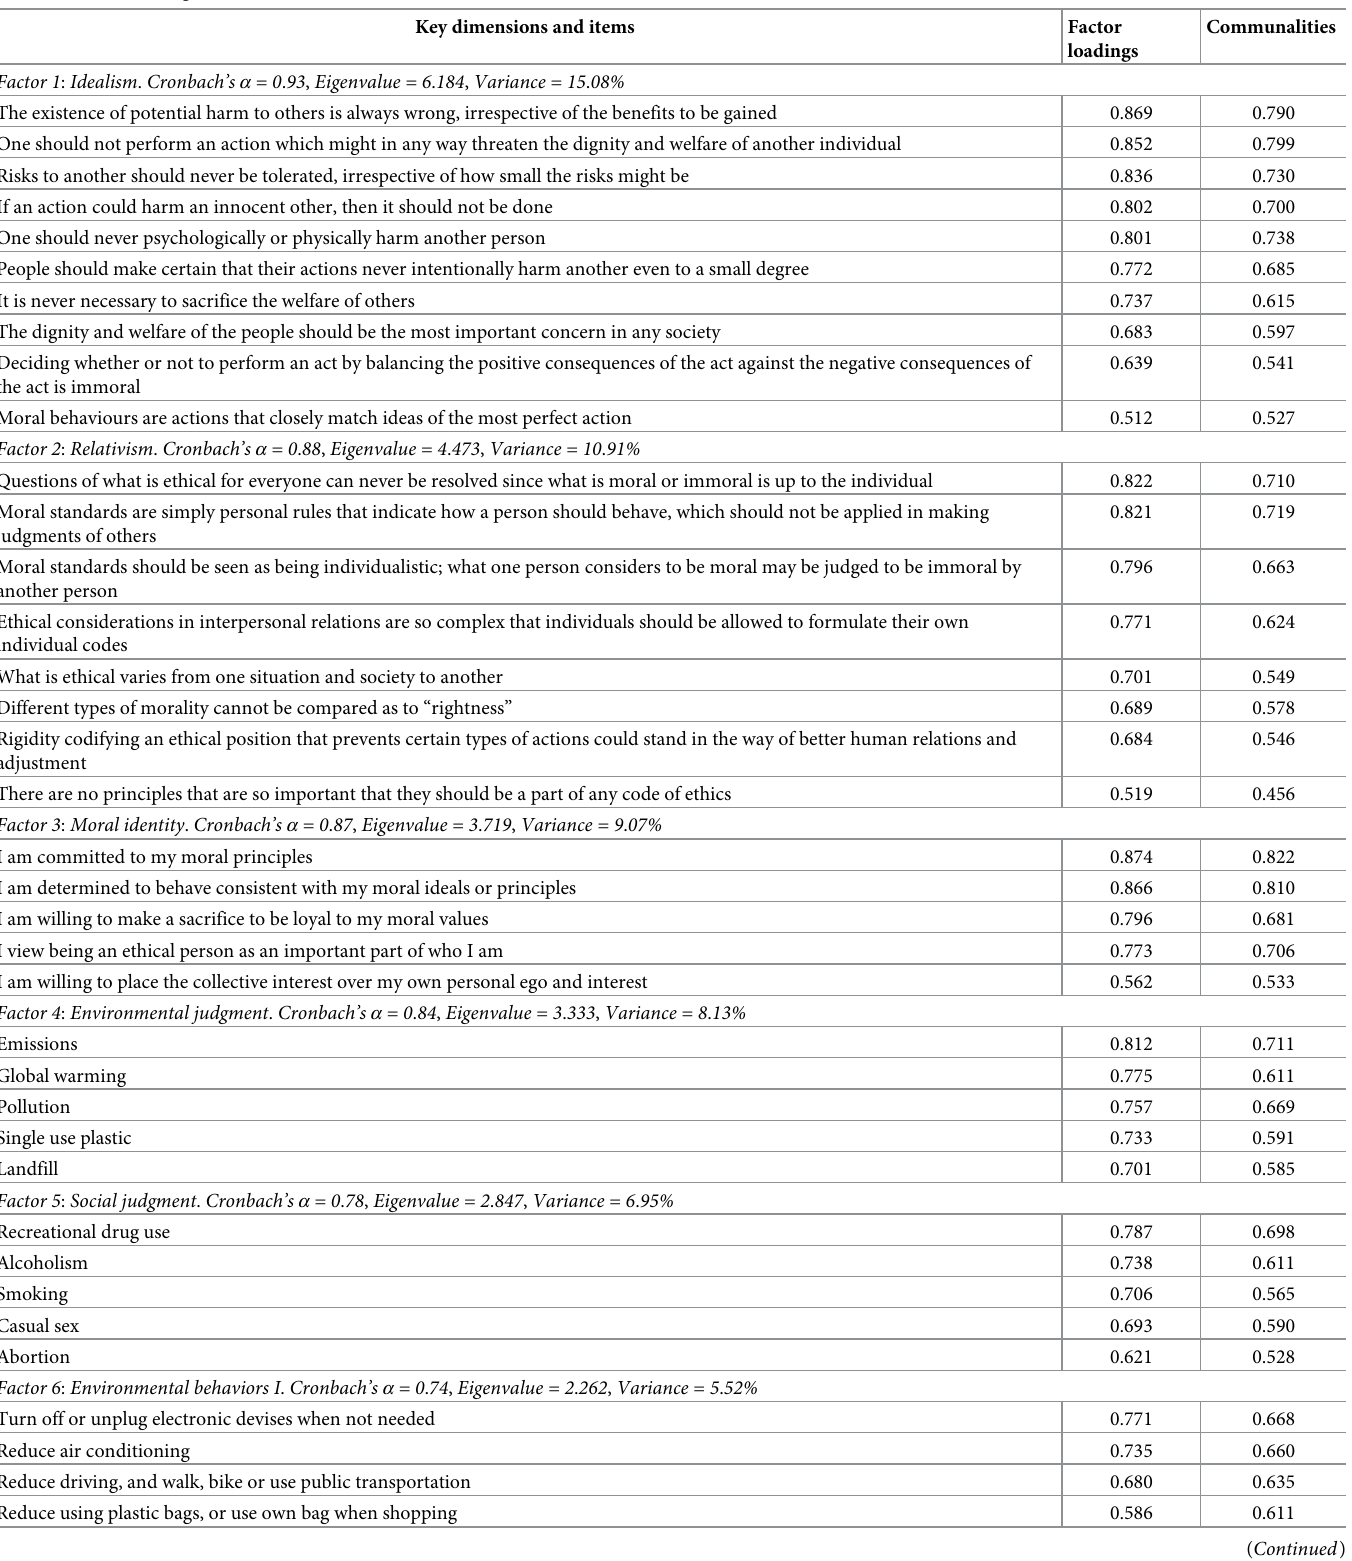
Table 3. Factor loadings and communalities. Key dimensions and items Factor